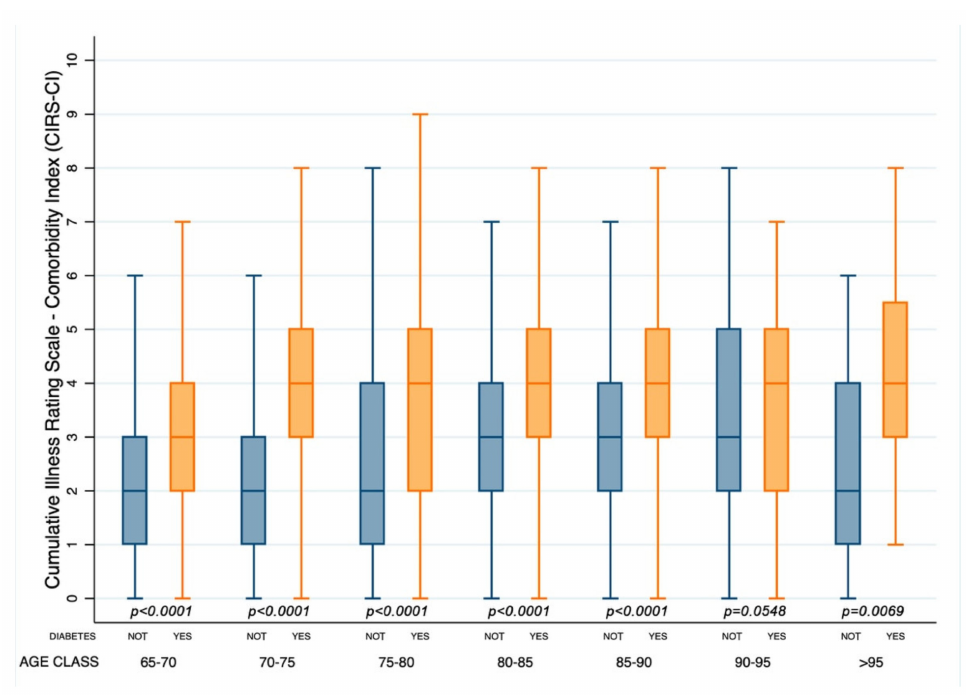
Figure 2. Box and whisker plot of the Cumulative Illness Rating Scale Comorbidity Index [CIRS-CI] according to age classes in patients with or without diabetes (Yes or Not). Moreover, subjects with diabetes between 65 and 80 years old had Barthel Index scores lower than people without diabetes (Figure 3).